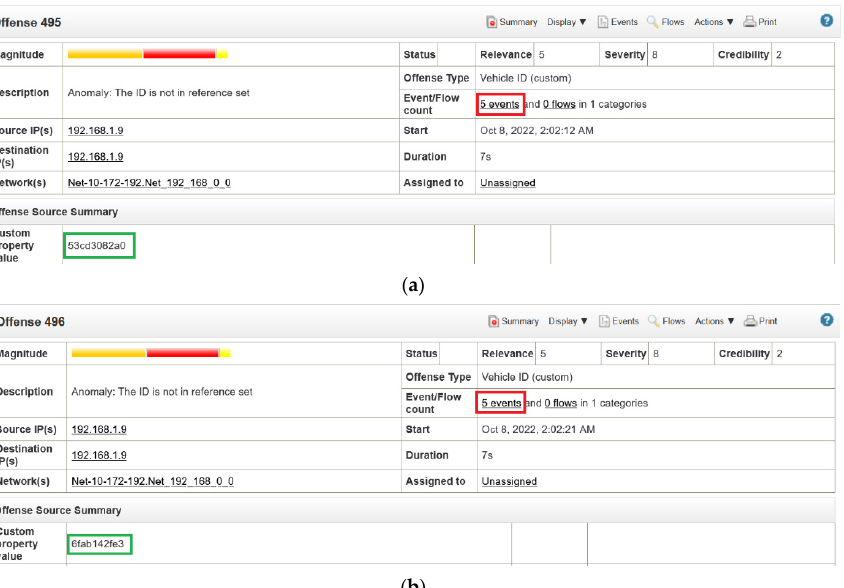
Figure 17. Generated offenses when a fuzzing attack is detected. ( a ) Shows the offense regarding the vehicle model OpelAstra with five identified attacks (red rectangle). In ( b ) the figure refers to the RenaultClio with five identified attacks.